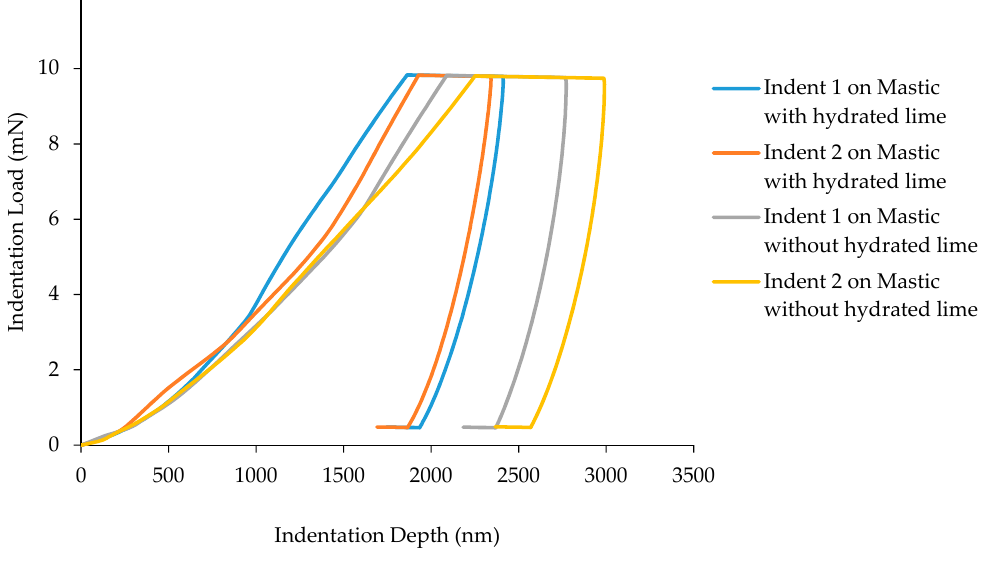
Figure 9. Load-displacement curve for mastic phases with hydrated lime.